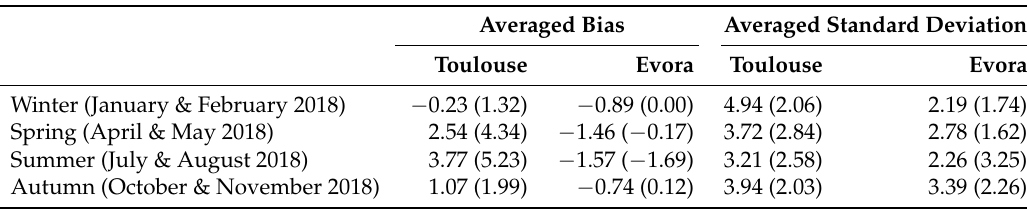
Table 3. Statistics of SEVIRI LSTs and model LSTs (in brackets) differences compared to local LSTs in Toulouse and Evora station during spring, summer, autumn and winter